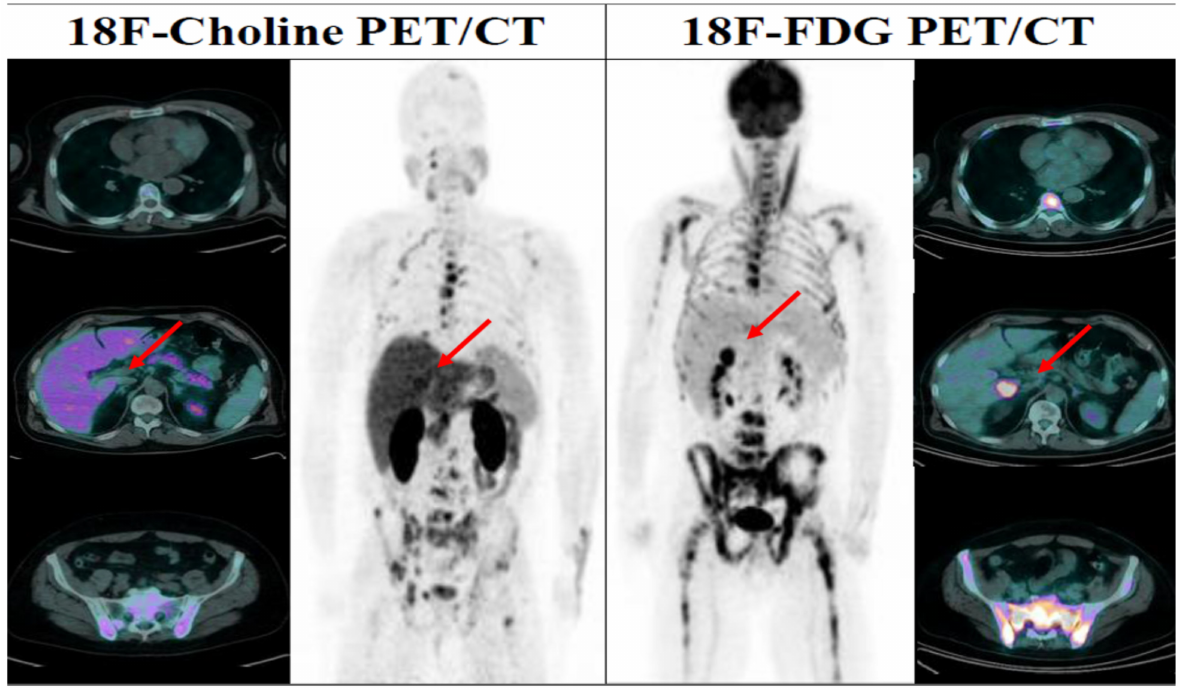
Figure 6. Comparison of 18F-Choline PET/CT and 18 F-FDG PET; 18F-FDG PET shows high osteo- medullary tracer uptake and a focal area of uptake in the liver (red arrows), while 18F-Choline PET shows only a few bones